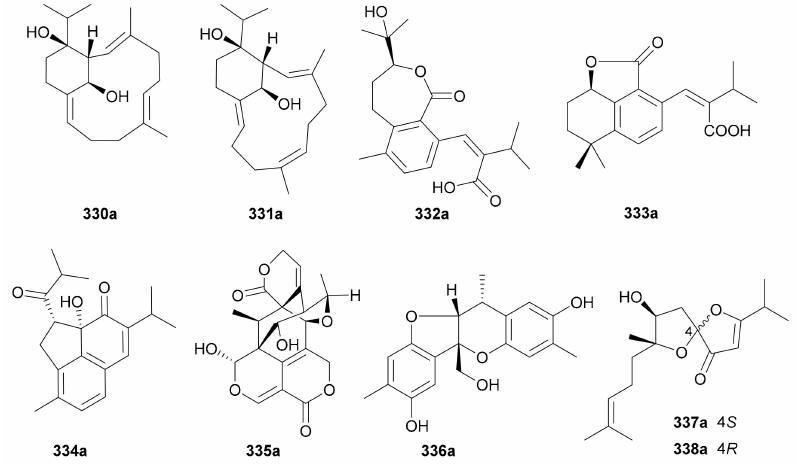
Figure 19. Structures of